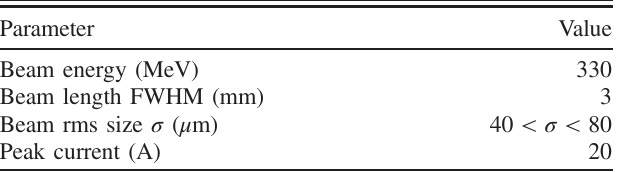
TABLE II. Beam parameters at the location where the corrugated plate could be installed at